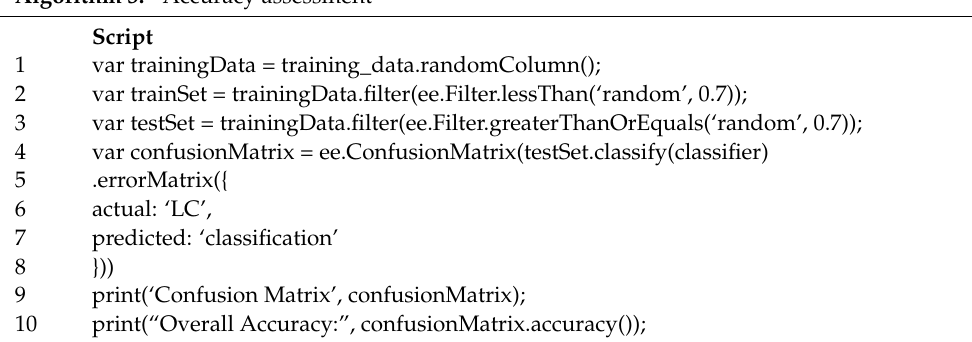
Algorithm 3: “Accuracy